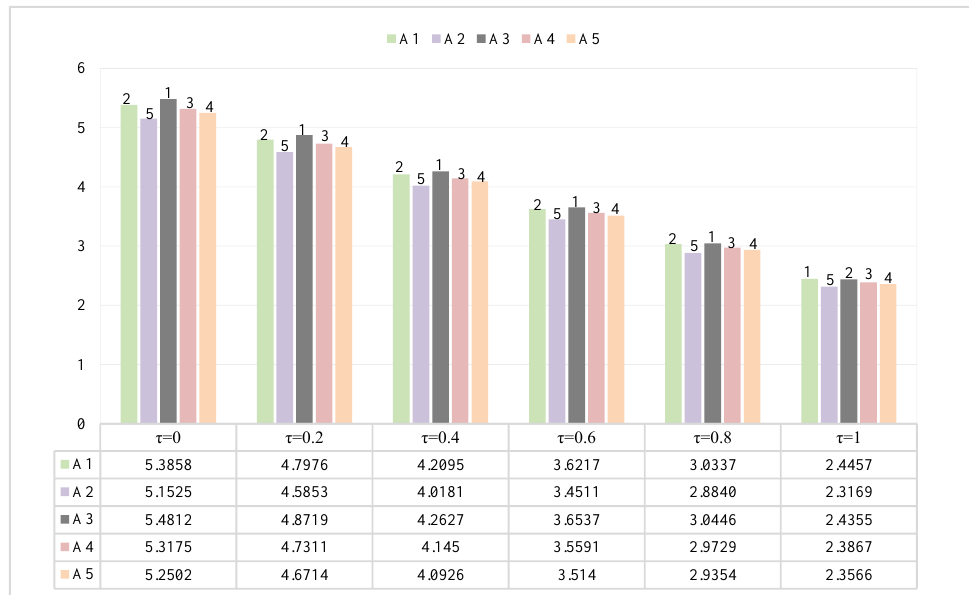
Figure 3. Ranking of alternative construction program managers.